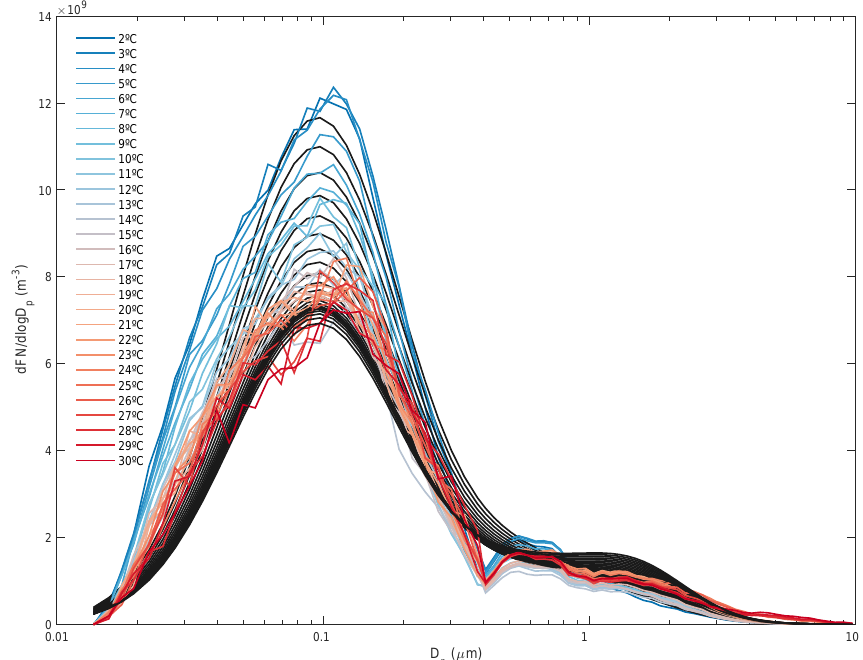
Figure 4. Mean aerosol number effective flux distribution of the corrected temperature ramp data (coloured lines) and corresponding log- normal fits constrained by fixed modal diameters and geometric standard deviations (black